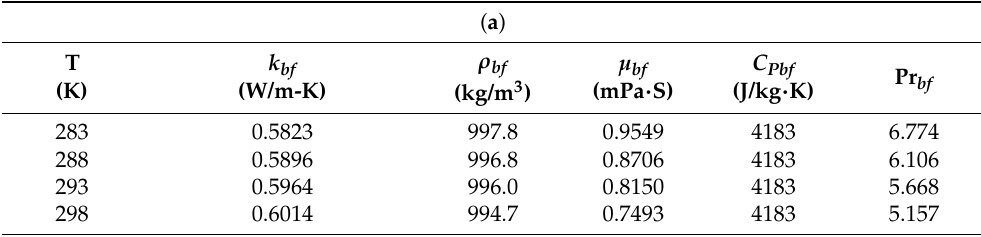
Table 1. ( a ). Thermo-physical properties of DI water. ( b ). Thermo-physical properties of hybrid